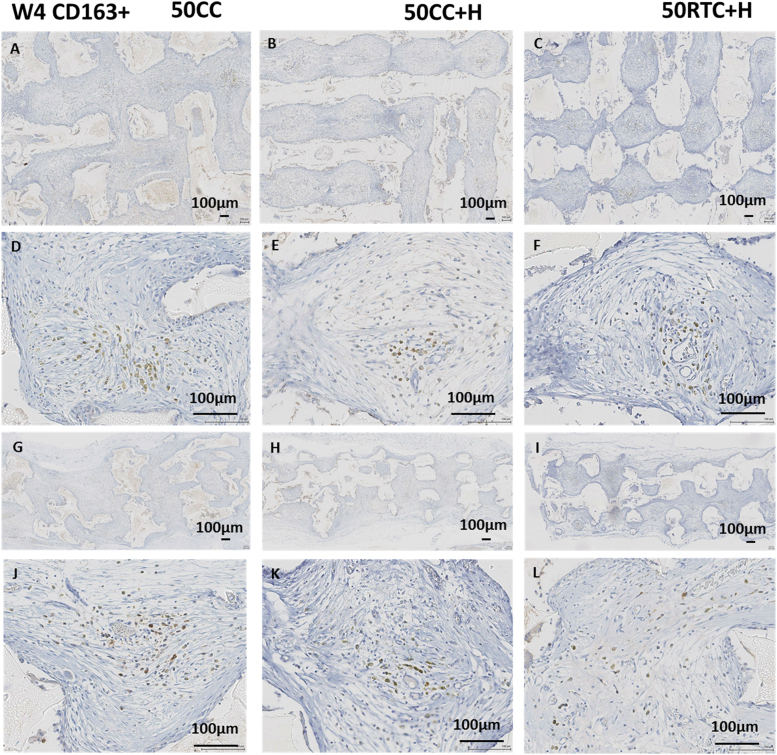
Immunohistochemistry of the host macrophage response towards scaffolds in vivo at week 4. Tissue integration of middle-in-plane (A-F) and cross-sectional view (G-L) of the scaffolds by CD163 (M2 macrophage marker) staining at (A-C, G-I) ×4 and (D-F, J-L) ×20 magnifications.